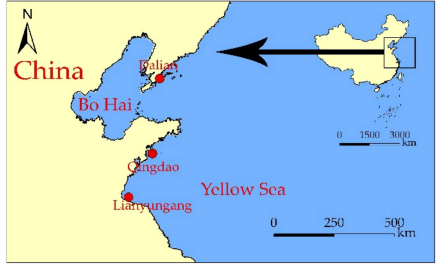
Figure 2. Cultural origins of